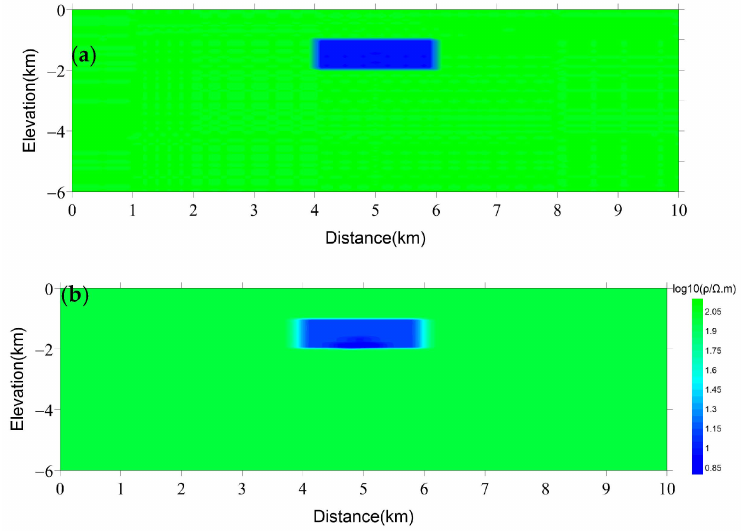
Figure 6. 2D-resistivity model ( a ) and quasi-2D-inversion-resistivity section ( b